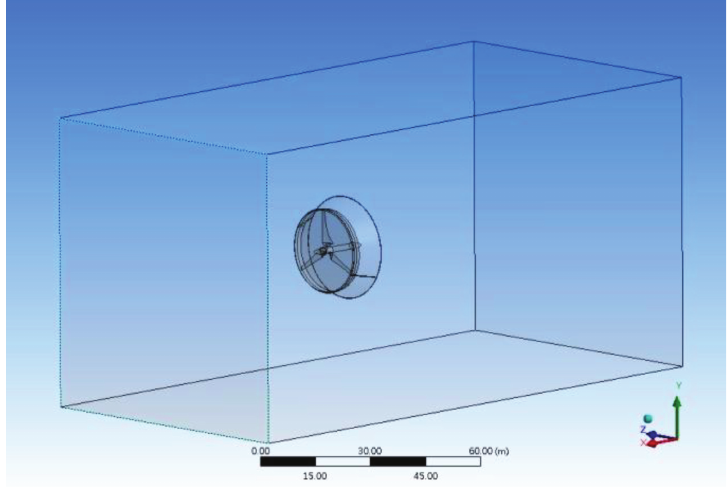
Figure 3. The computational domain for the shrouded rotor.